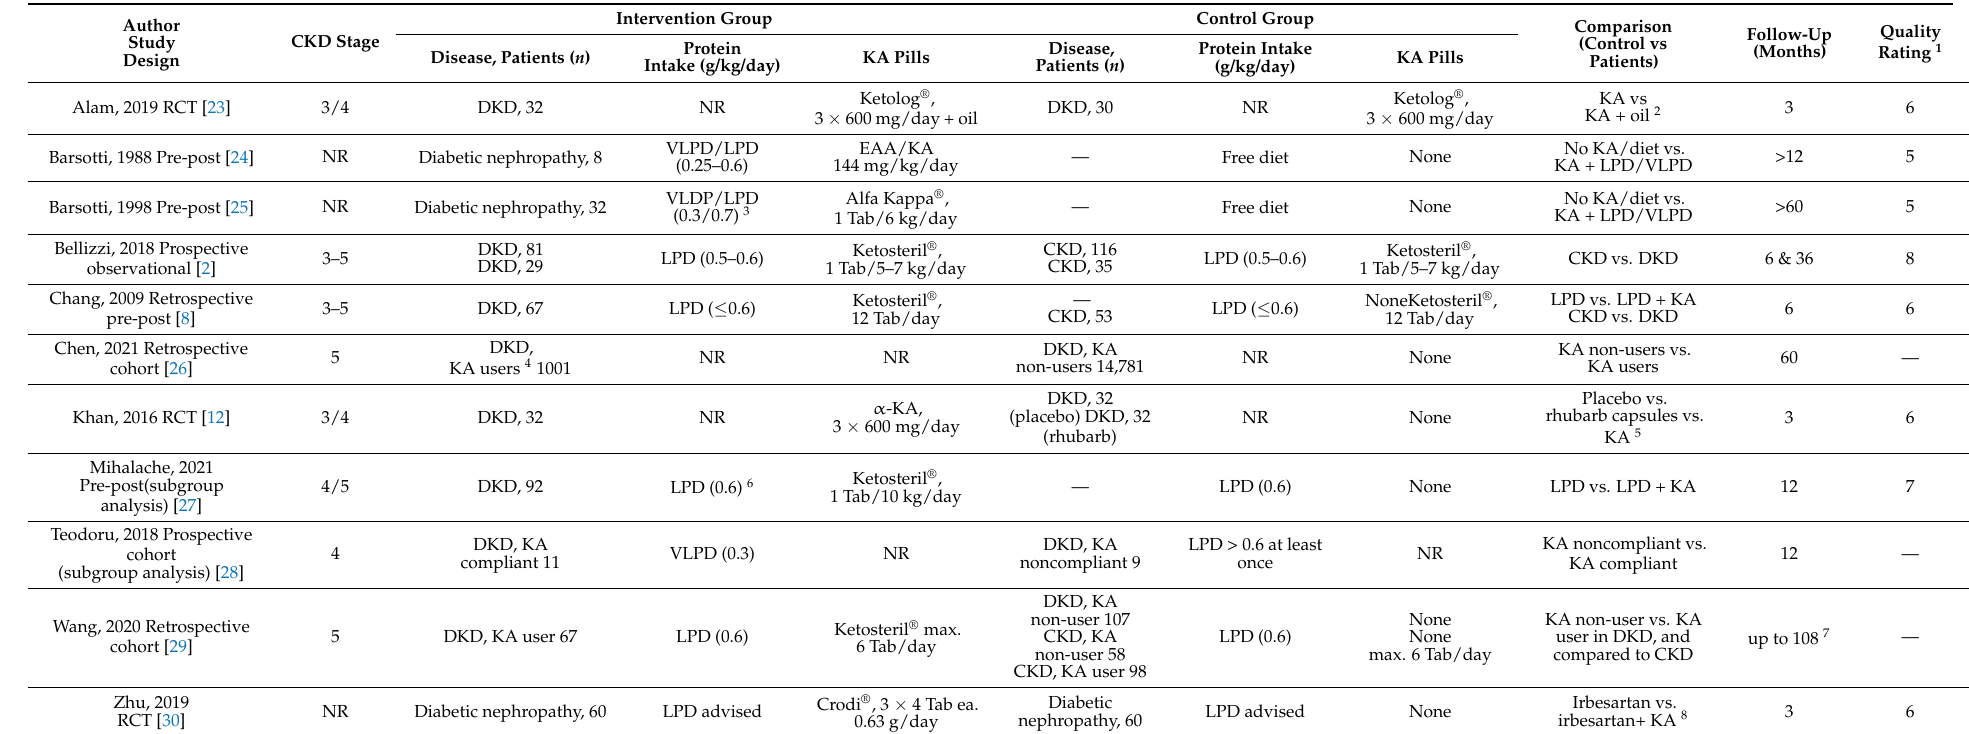
Table 2. Characteristics of studies included in the systematic